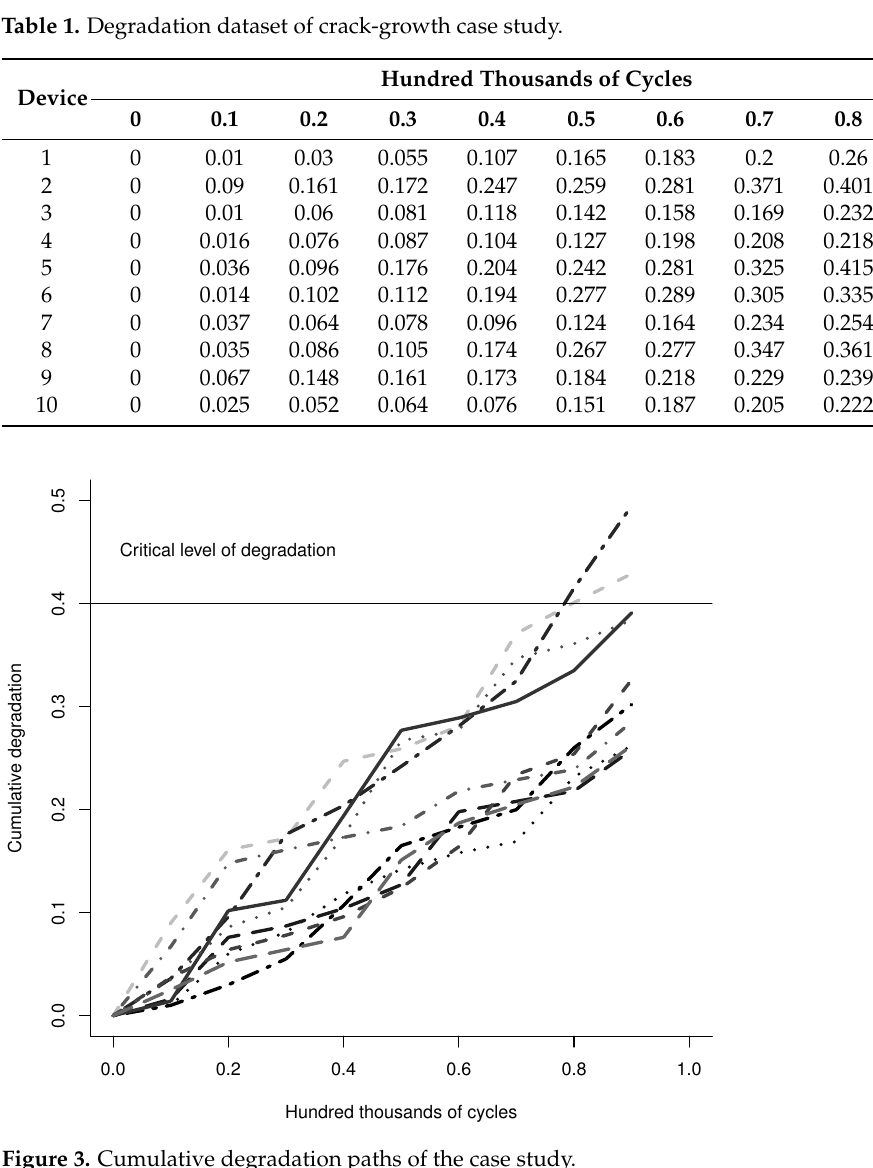
Figure 3. Cumulative degradation paths of the case